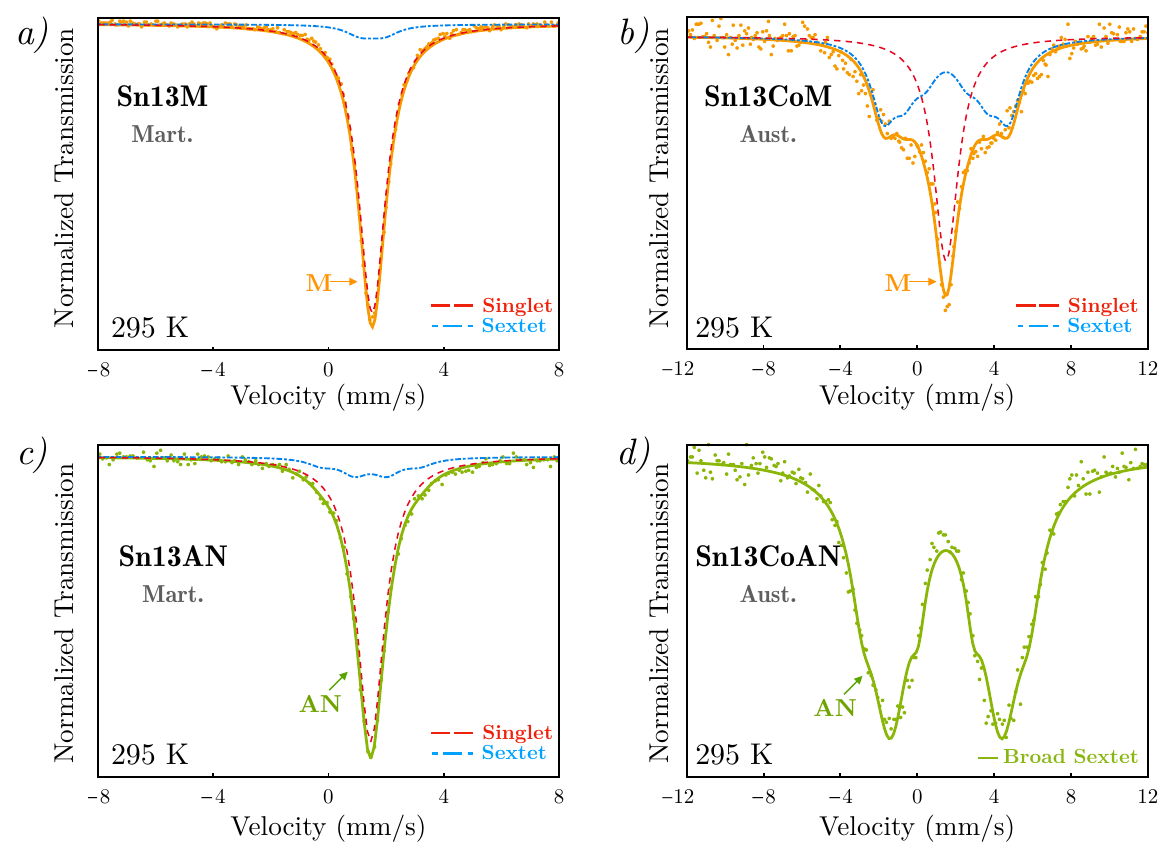
Figure 3. 119 Sn Mössbauer spectra for ( a ) Sn13M, ( b ) Sn13CoM, ( c ) Sn13AN and ( d ) Sn13CoAN samples measured at 295 K. The former three spectra have been fitted using a singlet and a magnetic component, while Sn13CoAN spectrum have been fitted using a single magnetic component (broad sextet). Aust. and Mart. labels refer to austenite and martensite phase,